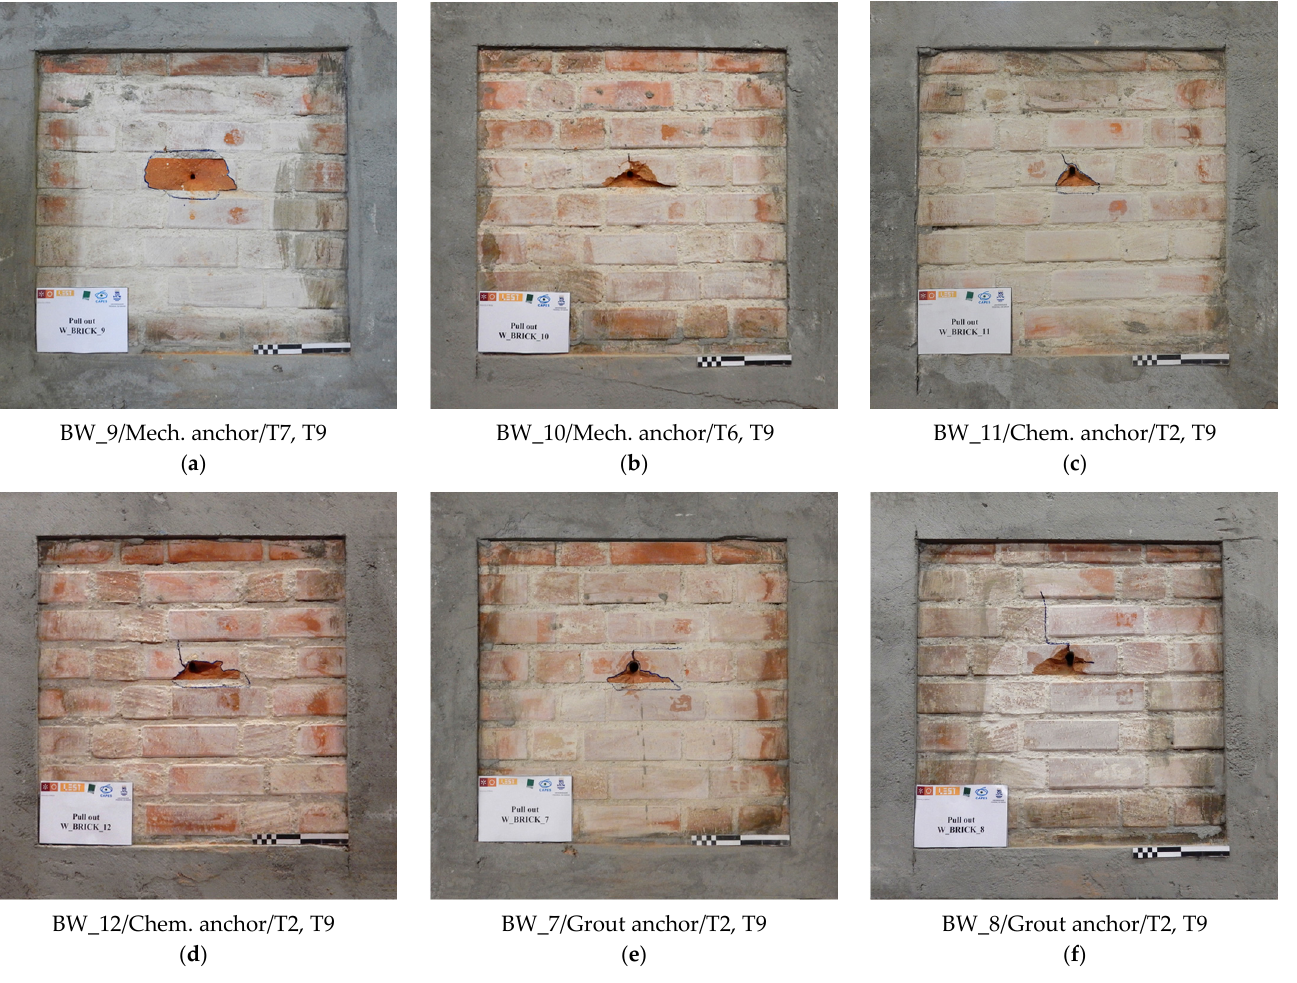
Figure 8. Failure modes obtained from the pull-out tests with inclined actuator: ( a ) BW_9; ( b ) BW_10; ( c ) BW_11; ( d ) BW_12; ( e ) BW_7; and ( f ) BW_8. ( c ) BW_11; ( d ) BW_12; ( e ) BW_7; and ( f )